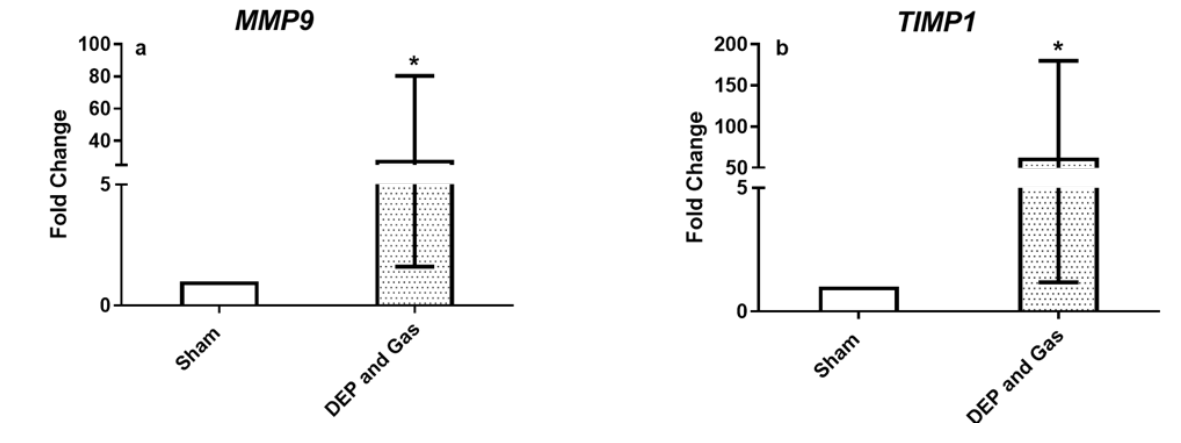
Figure 8. mRNA expression of tissue injury/repair markers following single combined exposure to diesel exhaust particles (DEP:12.7 µg/cm 2 ) and gaseous air pollutants (0.1 ppm NO 2 , 0.2 ppm SO 2 ). Fold change in MMP9 ( a ), and TIMP1 ( b ) in bronchial mucosa models developed at air – liquid interface (bro-ALI) following incubation for 24 h after exposure to sham (control: clean air exposure) and combined air pollutants. Data presented as median and 25th – 75th percentiles, fold change = 2- ΔCt of models/2 - ΔCt of sham -exposed bro-ALI. N = 3 donors and n = 2 replicates/donor). p < 0.05 *: significant compared to sham.